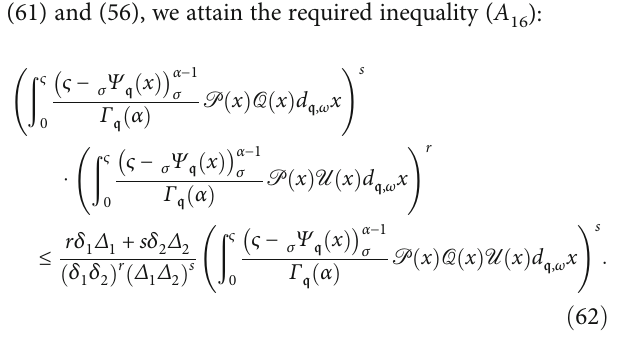
p Δ Δ / δ δ 1 2 1 2 δ Δ / δ Δ 2 2 1 1